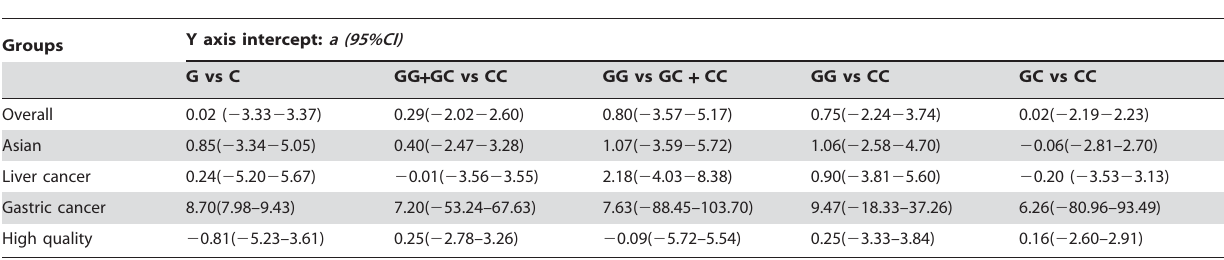
Table 4. Egger’s linear regression test to measure the funnel plot asymmetric.*